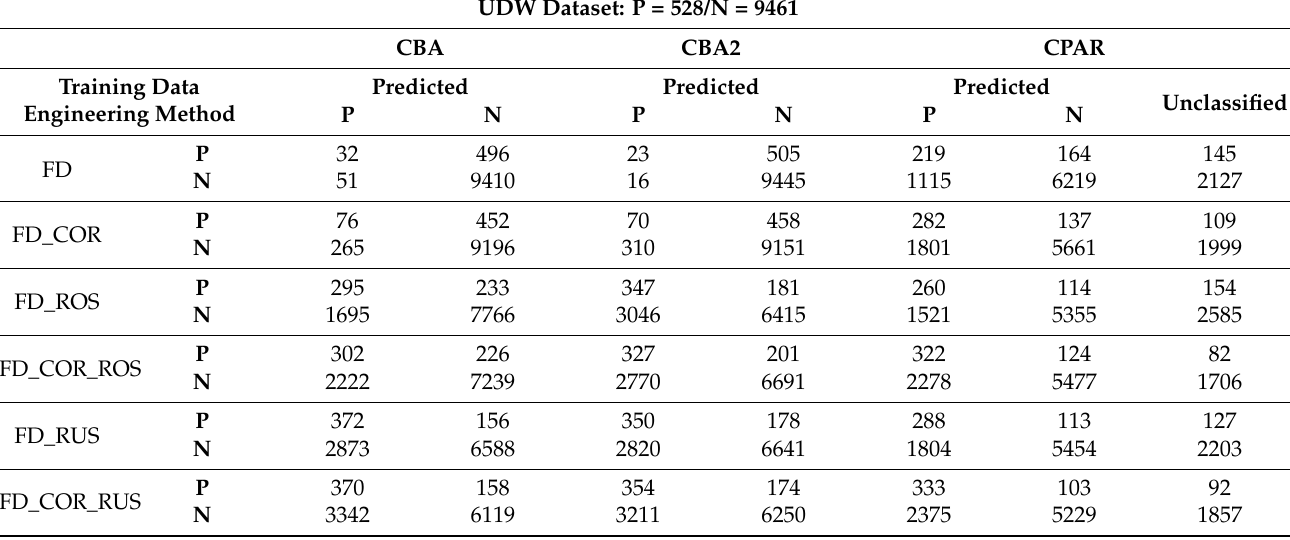
Table 6. UDW classification results (confusion matrixes) per algorithm and training data engineering